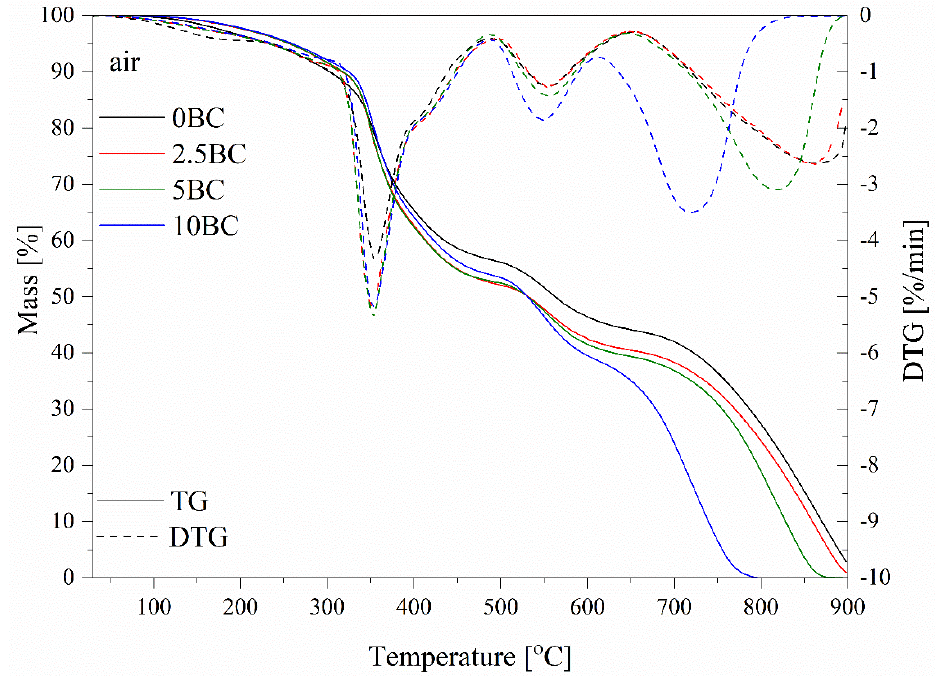
Figure 9. The diagrams of TG and DTG for analyzed materials obtained in air atmosphere. Table 4. Results of thermogravimetry (TGA) analysis for composites and biochar examined in nitrogen atmosphere.